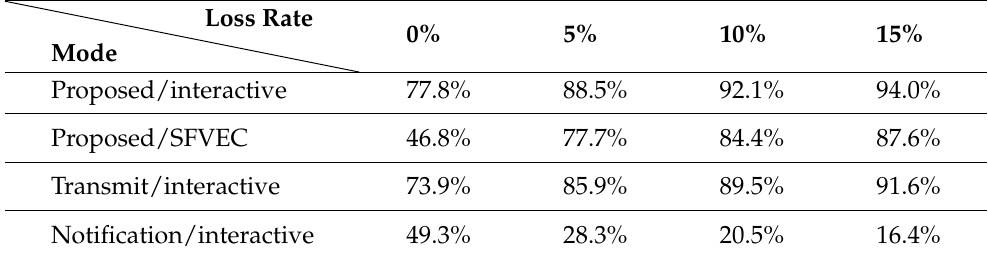
Table 4. Latency reduction